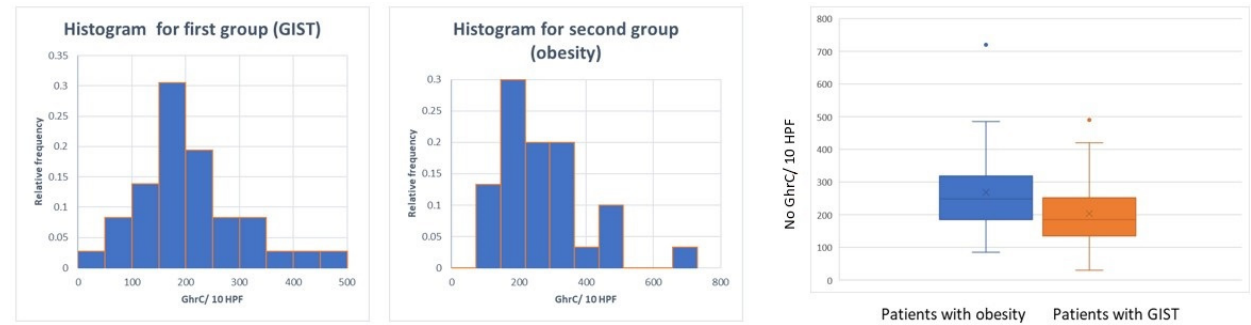
Figure 4. Distribution of GhrC in overlying mucosa of gastric GISTs vs. obese